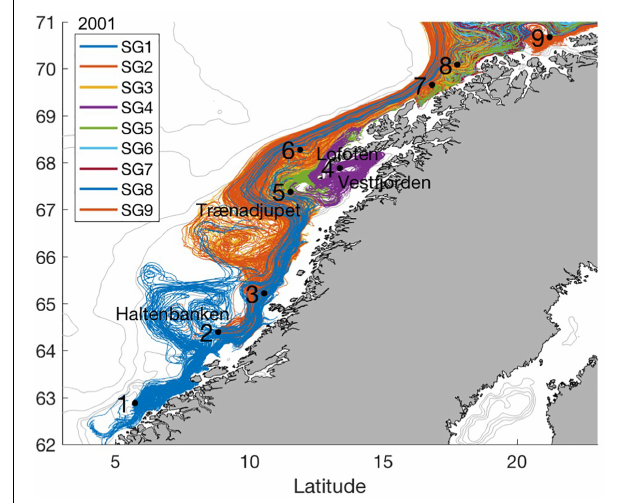
FIGURE 1 | SGs (black stars) and every 100th drift trajectory of eggs/larvae from spawning until late July during 2001.